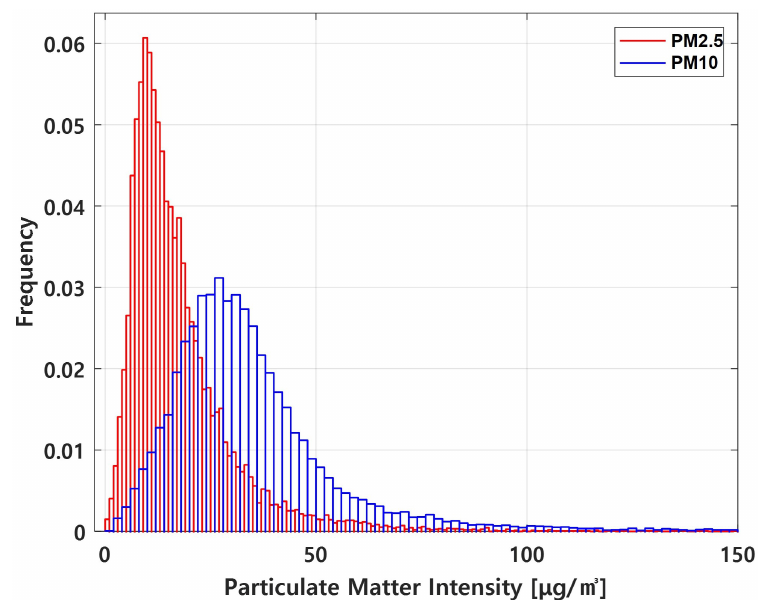
Figure 4. Histogram of PM2.5 and PM10 data collected from Jeju Island (January 2019– December 2021).